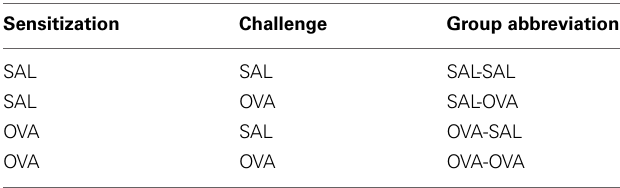
Table 1 | Mouse groups included in the mild airway inflammation model.